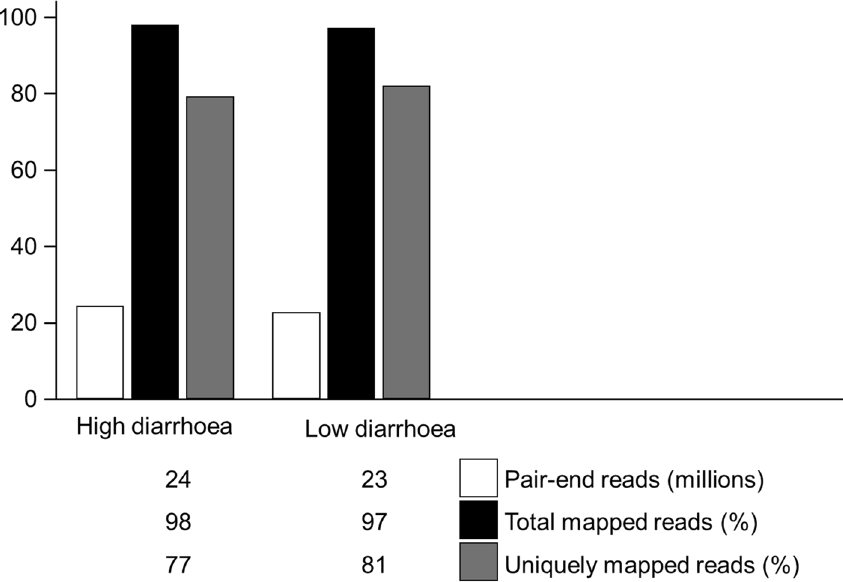
Figure 2. The mapping statistics for the RNASeq data. Each bar displays the mean total number of paired-end reads generated (white), the percentage of total reads successfully aligned against the reference genome (black), and the percentage of uniquely mapped reads